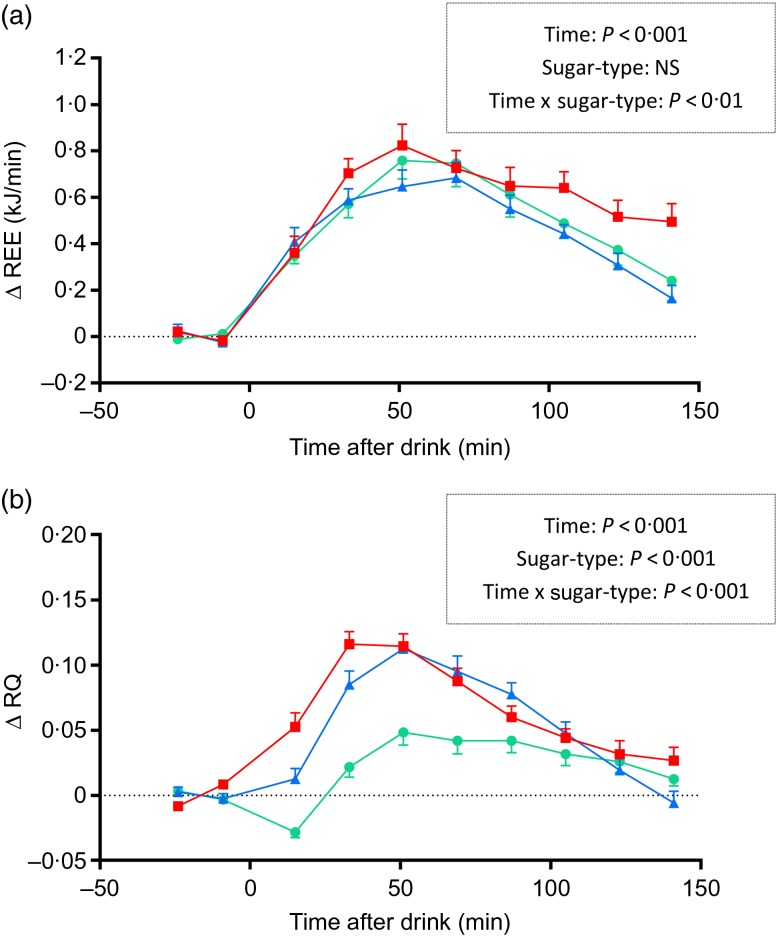
Time course of changes in (a) resting energy expenditure (Δ REE) and in (b) respiratory quotient (Δ RQ) after drinks containing glucose (–●–), galactose (–▲–) and fructose (–■–). Values are means, with standard errors represented by vertical bars. The results of repeated-measures ANOVA assessing statistical differences for the effects of time, sugar-type, and sugar-type × time interaction are provided in the rectangular boxes.